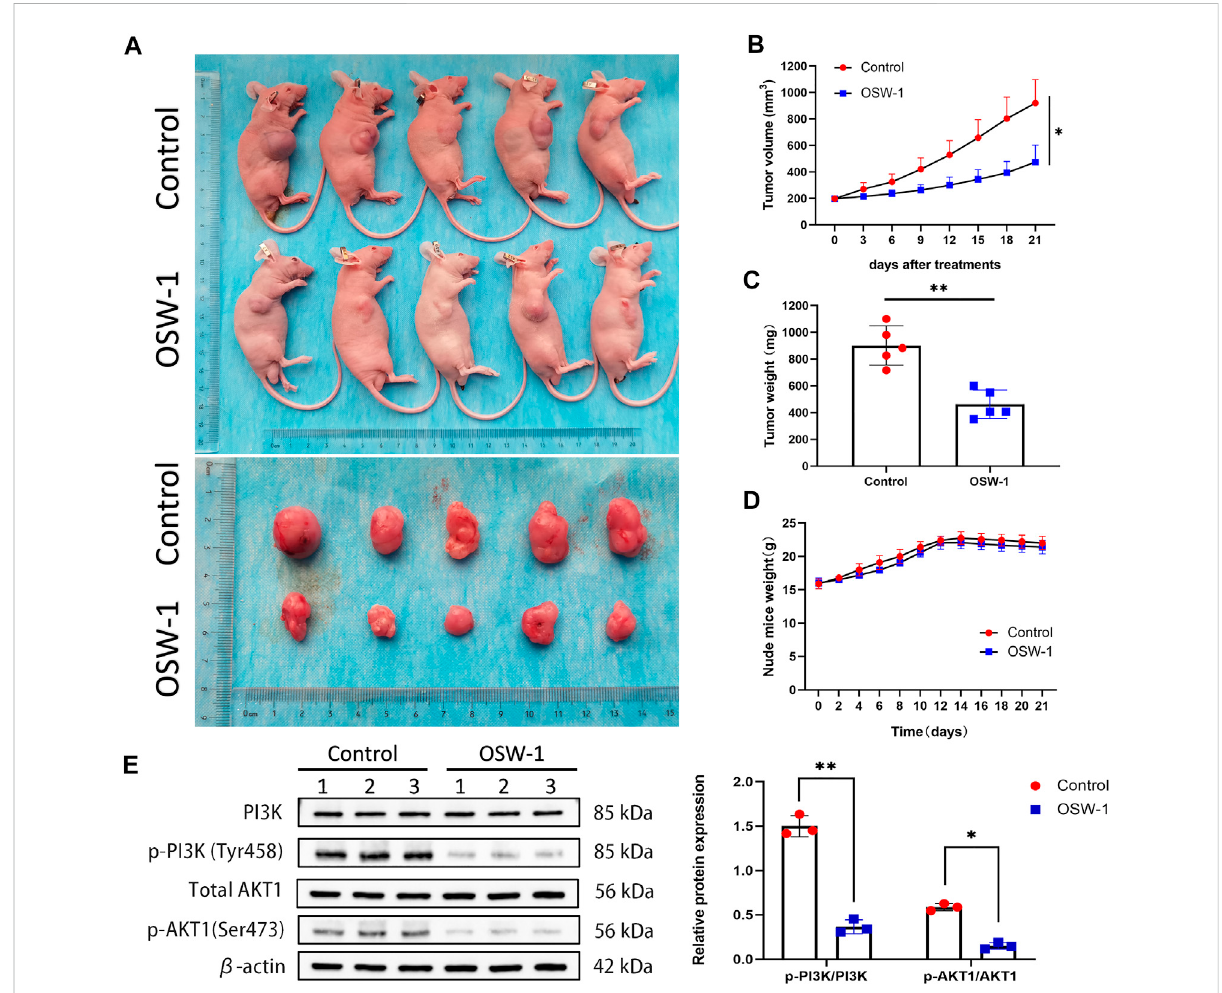
FIGURE 8 OSW-1 inhibited tumor growth in the xenograft model mice (A) The tumors of control mice and OSW-1-treated mice were extracted and photographed (B,C) Inhibitions in the average volume and weight of glioma xenografts were observed after 21 days of OSW-1 treatment (D) Body weightchangesofmiceduring21daysofexposure (E) Westernblottingoftumortissuelysates.* p < 0.05,** p <